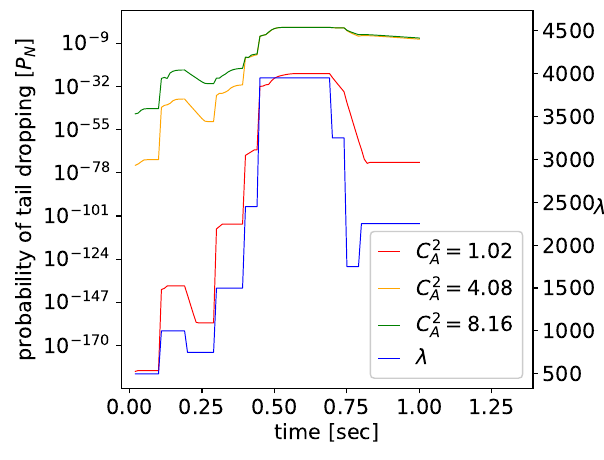
Figure 17. Station S 4: p N ( t ) for different C 2